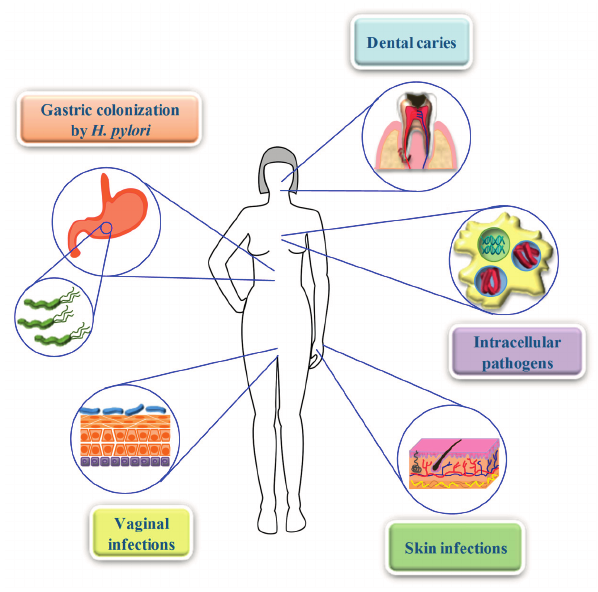
Figure 3. Body districts characterized by an acidic pH, where hep-20 could express its potentiated antimicrobial properties in the control of both bacterial and fungal